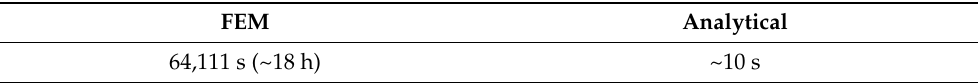
Table 2. Computational time required by the methods used.